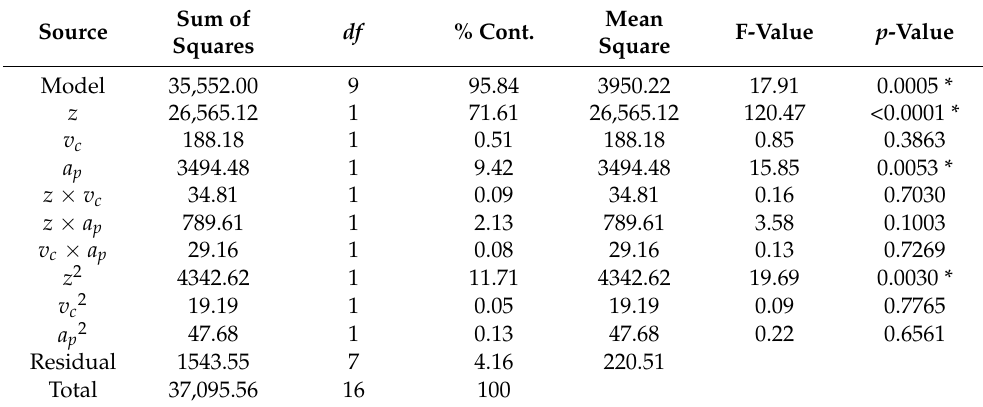
Table 6. ANOVA for the resultant force (*: significant, p -value < 0.05).